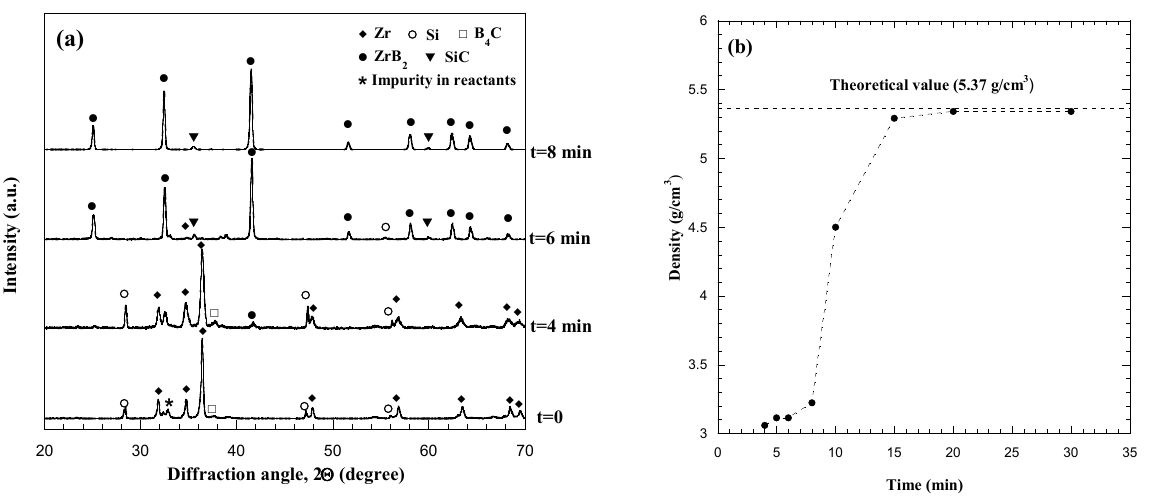
Figure 6. Compositional ( a ) and sample density ( b ) changes as a function of the